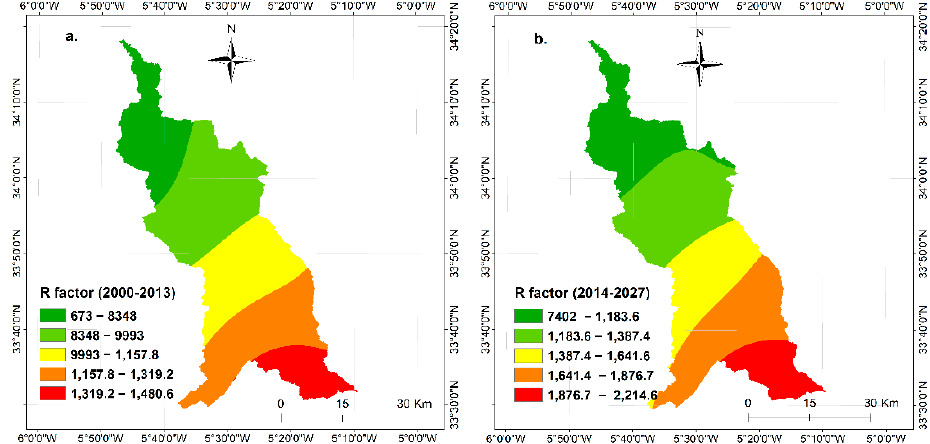
Figure 5. Spatial distribution of erosivity (R) for R’Dom watershed. ( a ) 2000/2013 and ( b ) 2014/2027.